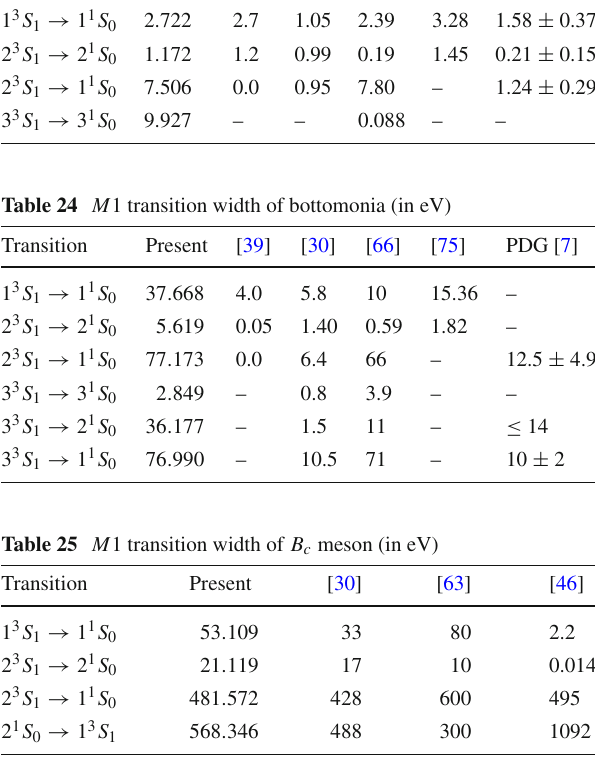
Table 22 E 1 transition width of B c meson (in keV) Transition